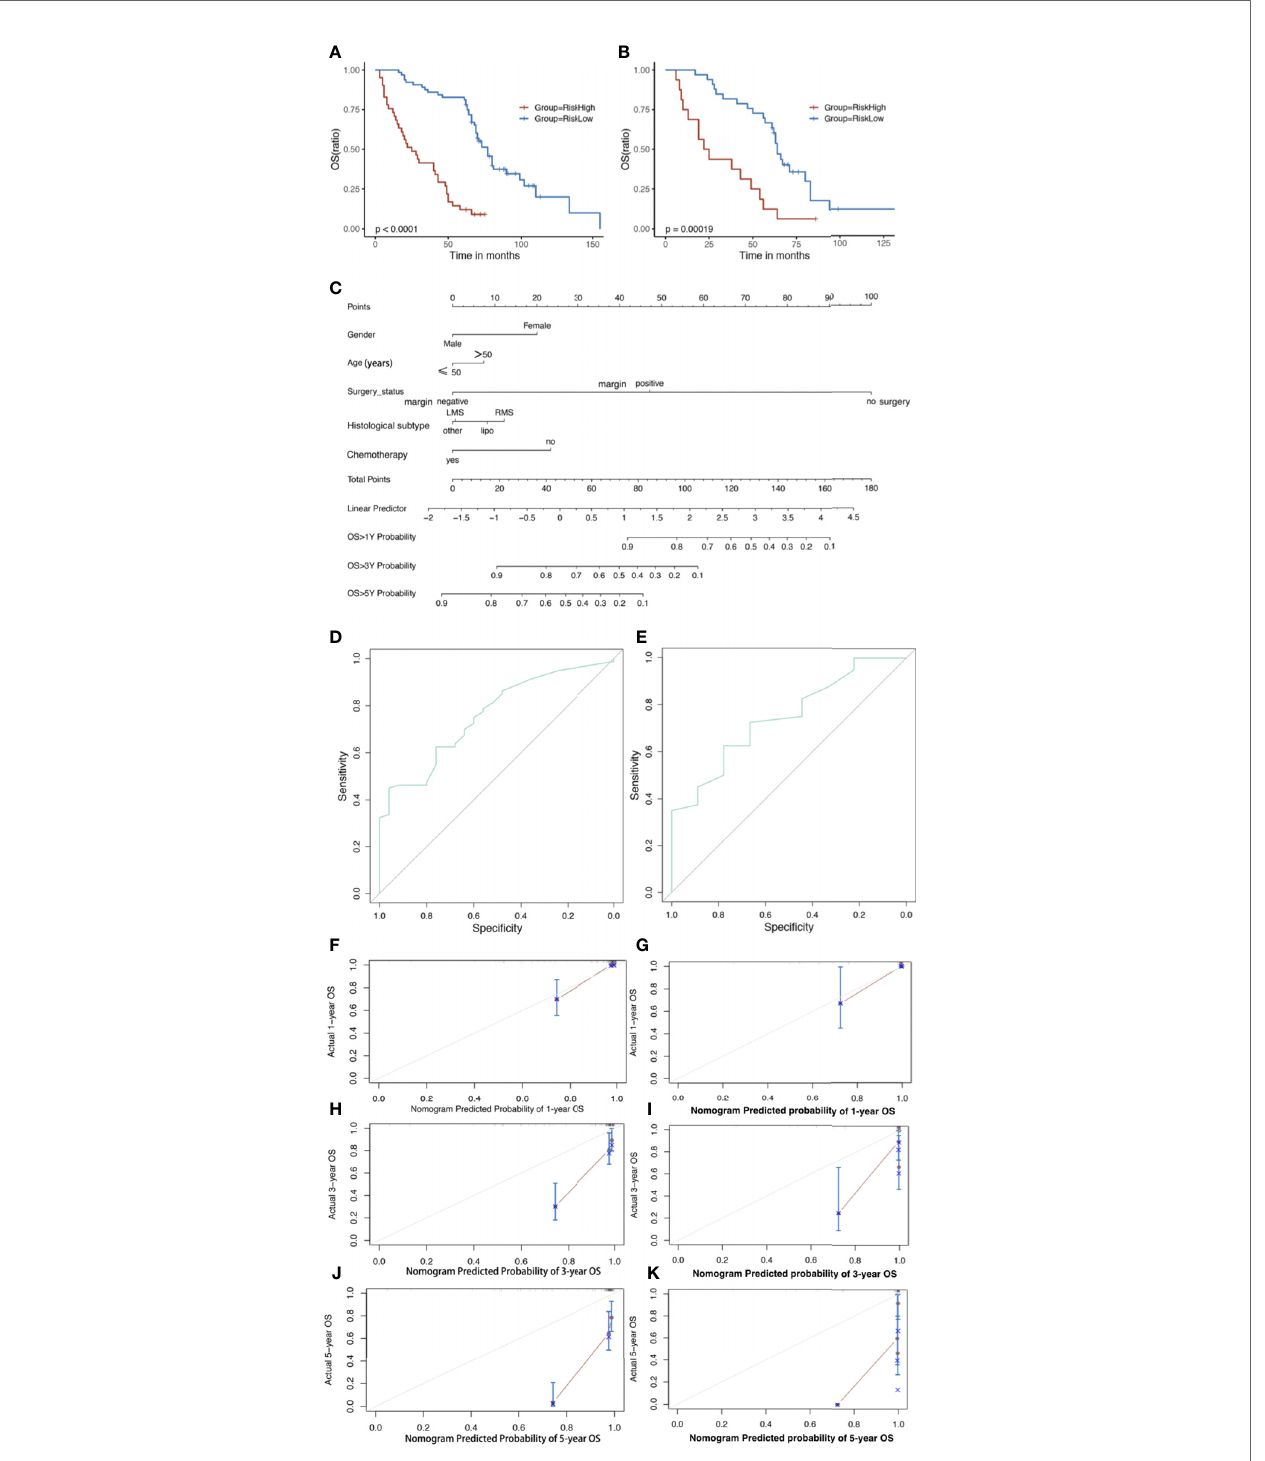
FIGURE 4 | The Kaplan – Meier survival curve of risk model predicting OS in the training set (A) and validation set ( B ). Nomogram predicting 1-, 3- and 5-year OS (C) of GS patients. The nomogram is used by fi rst giving each variable a score on its point scale. Then, add all the points and draw a vertical line from the total point scale to the axis predicting OS to obtain the probability. Receiver operating characteristic (ROC) curve of the nomogram of (D) Training and (E) validation set predicting OS. The calibration plots for the training set of (F) actual 1-, (H) 3-, and (J) 5-year OS; and validation set of (G) actual 1-, (I) 3-, and (K) 5-year OS. The 45-degree line represents an ideal match between the actual survival (Y-axis) and nomogram-predicted survival (X-axis). The perpendicular line means 95% con fi dence intervals. Closer distances from the points to the dashed line indicate higher prediction accuracy. OS, overall survival; AUC, area under the